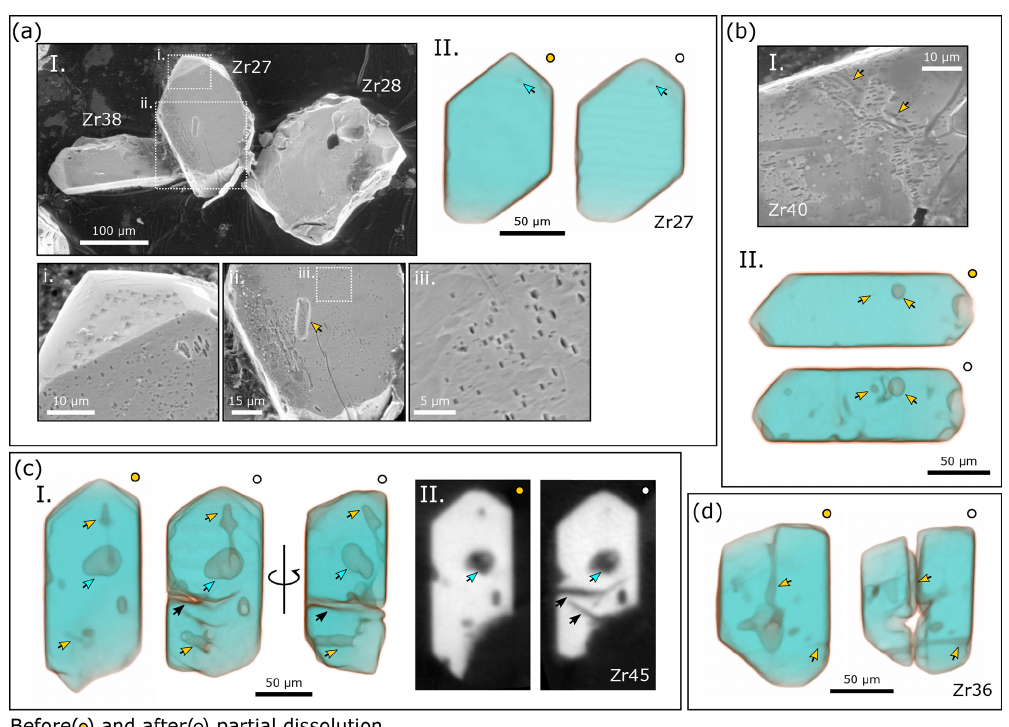
Figure 14. SE and µCT images of KR18-04 grains pre- and post-chemical abrasion at 180 ◦ C for 12h. (a) Subpanel (I) shows a low- magnification SE image of zircon samples Zr38, Zr27, and Zr28 and higher-magnification images of Zr27, showing close-up images of rectangular and triangular etch pits and the removal of a surface-reaching inclusion (yellow arrow). (II) Semi-transparent 3D rendering of µCT data for Zr27. Arrows highlight an inclusion inferred to have survived partial dissolution. (b) Subpanel (I) shows an SE image of Zr40 with linear etch pit arrays likely indicative of dislocations. (II) Semi-transparent 3D rendering of µCT data highlighting inclusions that dissolved. (c) Subpanel (I) shows a semi-transparent 3D rendering of µCT data for Zr45. Teal arrows highlight a large inclusion inferred to have survived partial dissolution, while yellow arrows mark inclusions that dissolved. Black arrows mark acid paths. (II) 2D µCT image slices. Teal arrows mark the same multi-phase inclusion in (I). Black arrows mark acid paths not apparent in the before imagery dataset. (d) Semi- transparent 3D rendering of µCT data for Zr36. Yellow arrows highlight surface-reaching inclusions removed by partial dissolution, resulting in a large cavity in the grain’s